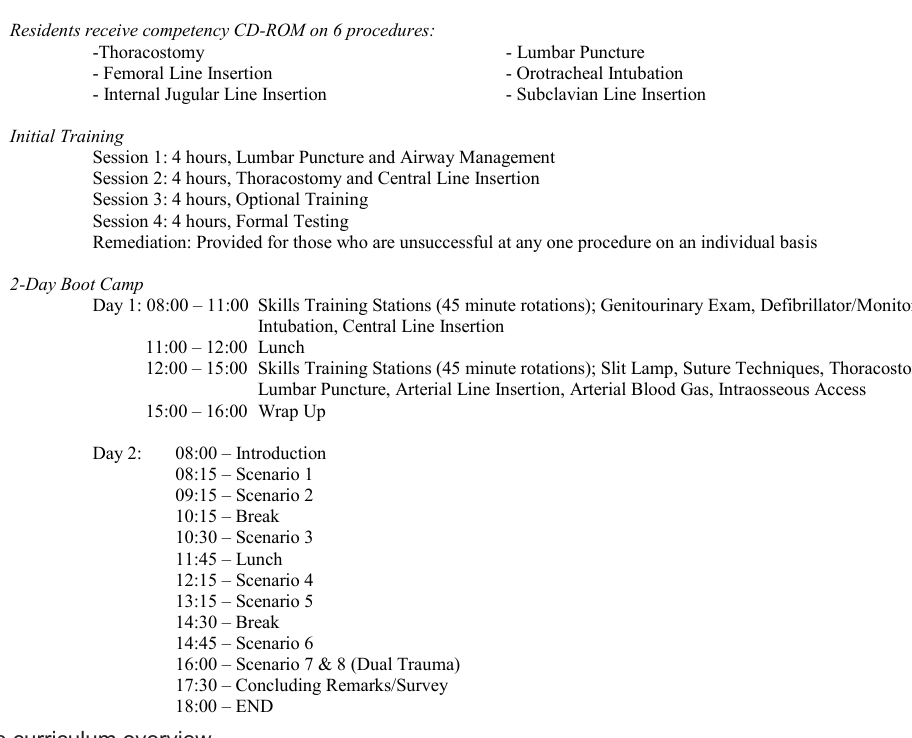
Figure 1. Boot camp curriculum overview